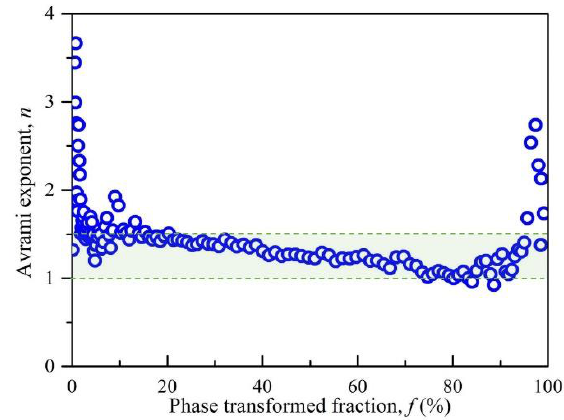
Figure 6. The local Avrami exponent (blue circle) as a function of phase transformed fraction of Al 0.25 CoCrFeNi high-entropy alloy that heated at 4 K/min. The green zone represents the range of n from 1~1.5.